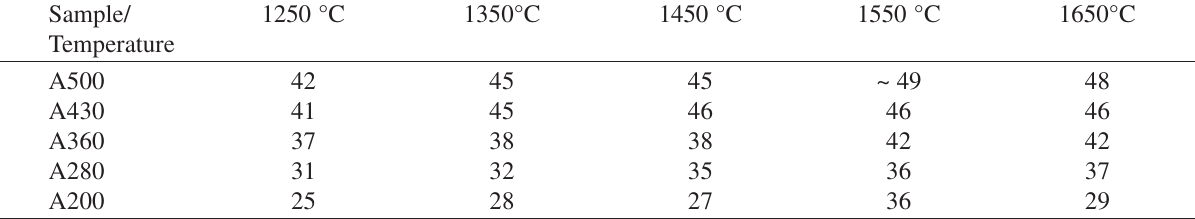
samples at different 2